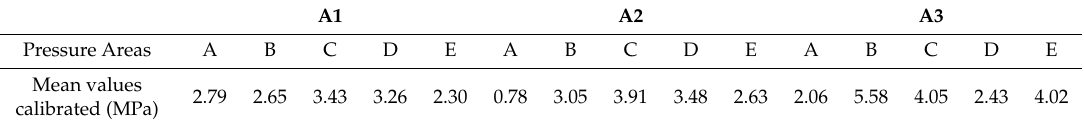
Table 3. Mean values calibrated of the 3 active aligners. Active areas did not always have corresponding passive areas, which is why only some active pressure values are calibrated. A1 A2